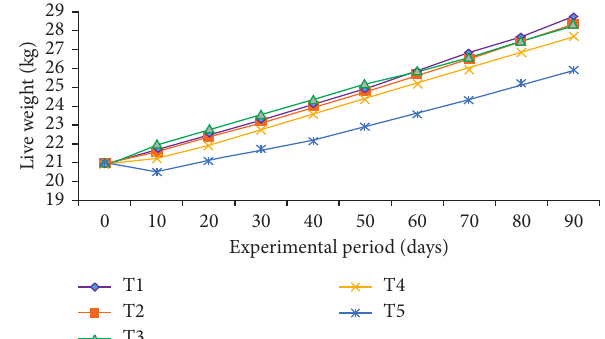
Figure 2: Trends in body weight changes of growing Bonga lambs fed on Rhodes grass hay basal diet and supplemented with dried mulberry and Vernonia mixed leaves’ meal as a substitute to NSC of concentrate mix during the 90-day feeding period.